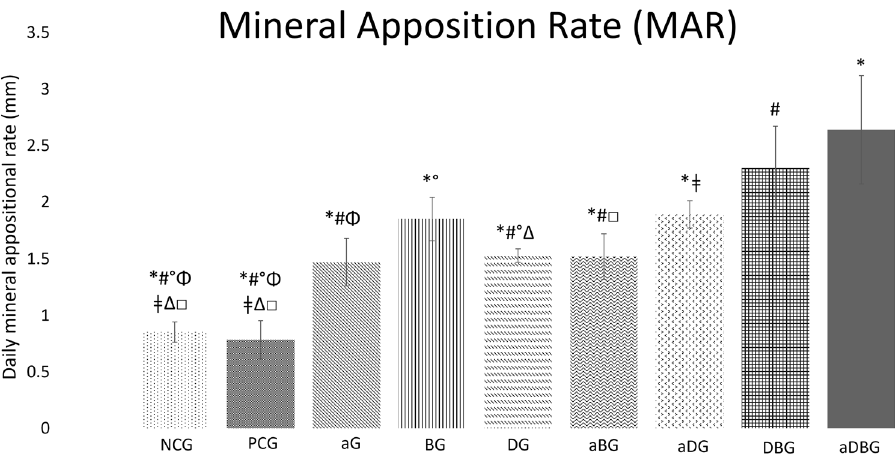
Figure 4. Graph representing the daily group averages of bone mineralization ( p < 0.001, represented by *, when compared to aDBG; #, when compared to DBG; ǂ , when compared to aDG; °, when compared to BG; p < 0.05, represented by Δ, when compared to DG; □ , when compared to aBG; Φ, when compared to aG).